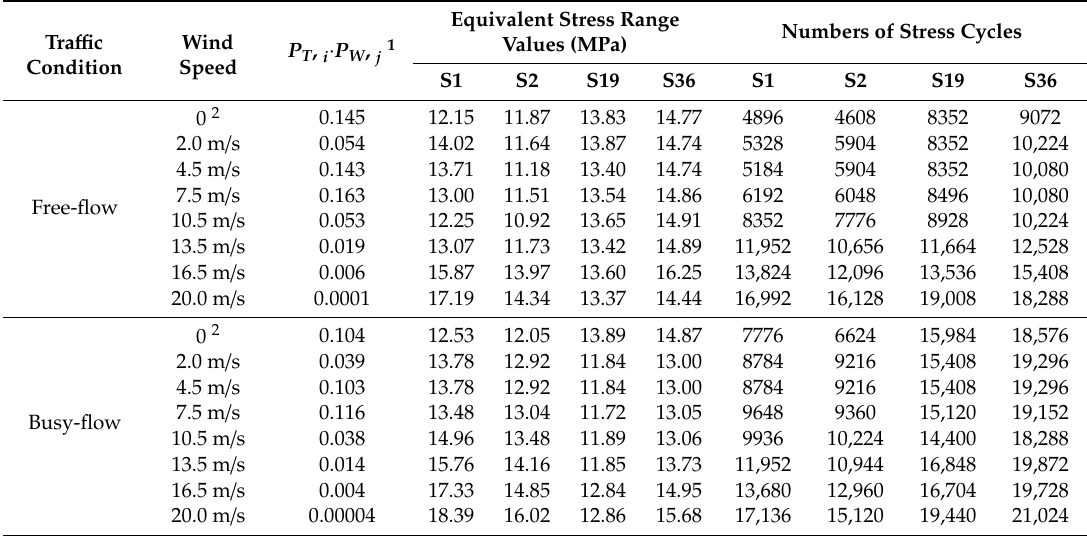
Table 8. Stress ranges and number of stress cycles due to combined wind and tra ffi c loads in one day. Tra ffi c Condition